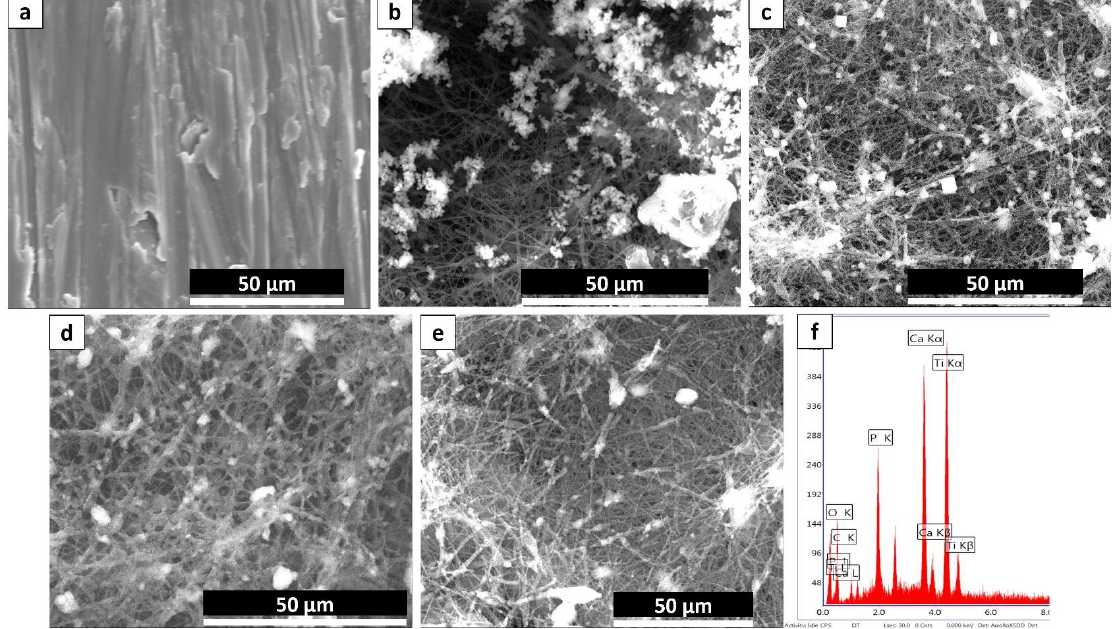
Figure 4. SEM images of ( a ) An, ( b ) PCL ( c ) PCL with 2 wt %TiO 2 ( d ) PCL with 5 wt %TiO 2 and ( e ) PCL with 7 wt %TiO 2 after immersing in SBF for 21 days. ( f ) EDS analysis results for the newly formed calcium and phosphate of PCL with 5 wt % TiO 2 .